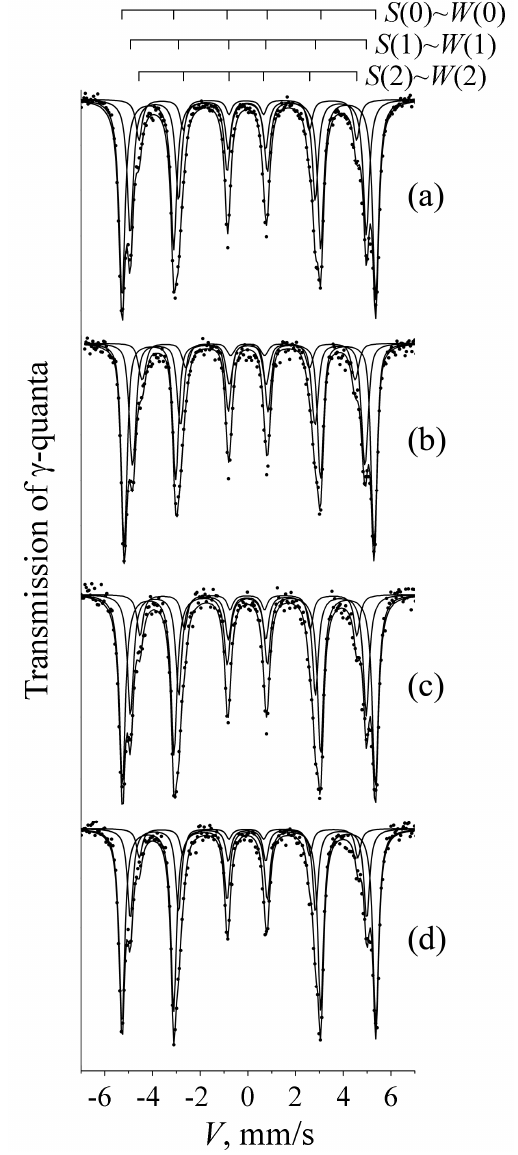
Figure 4. Spectra for the alloy Fe 93.2 Mn 6.8 . Treatment (state): ( a ) annealed at 1073 K (as-received), ( b ) annealed at 773 K, 1 h (aged); ( c ) as-received and HPT at 80 K; ( d ) as-received and HPT at 573 K.